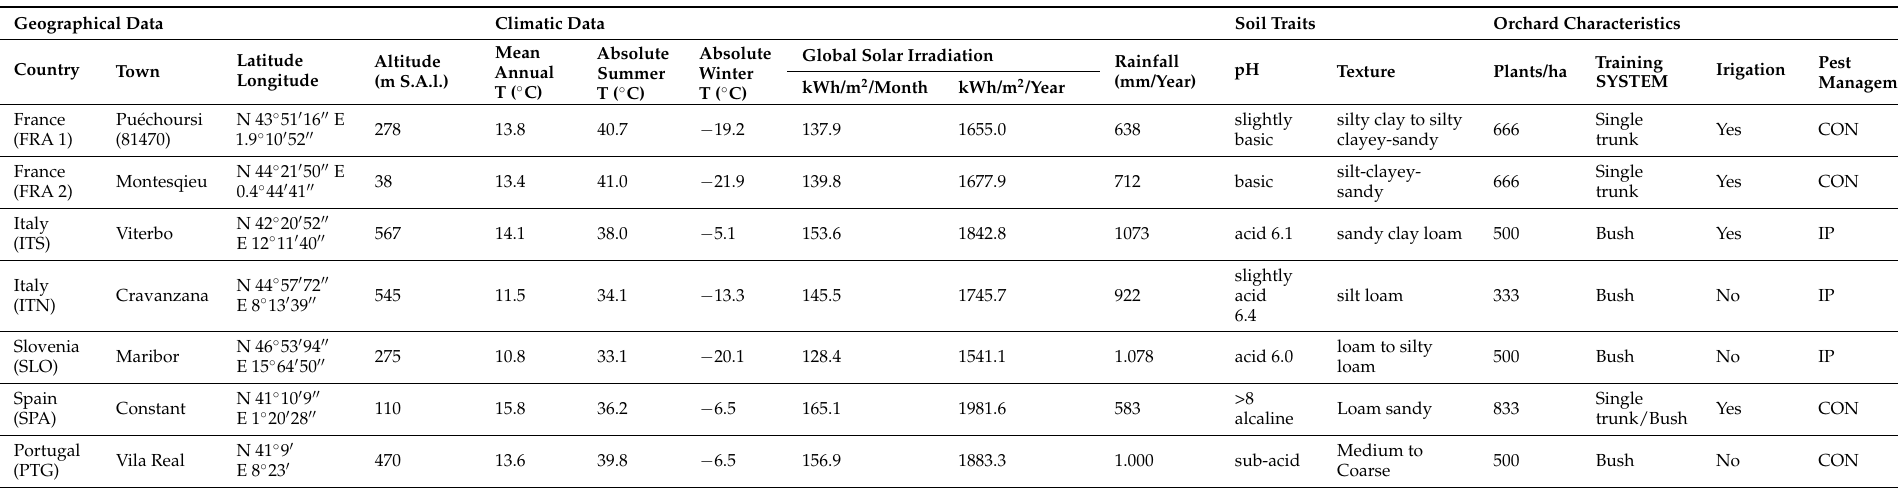
Table 5. The geographical, climatic, soil, and orchard characteristics of the six cultivation